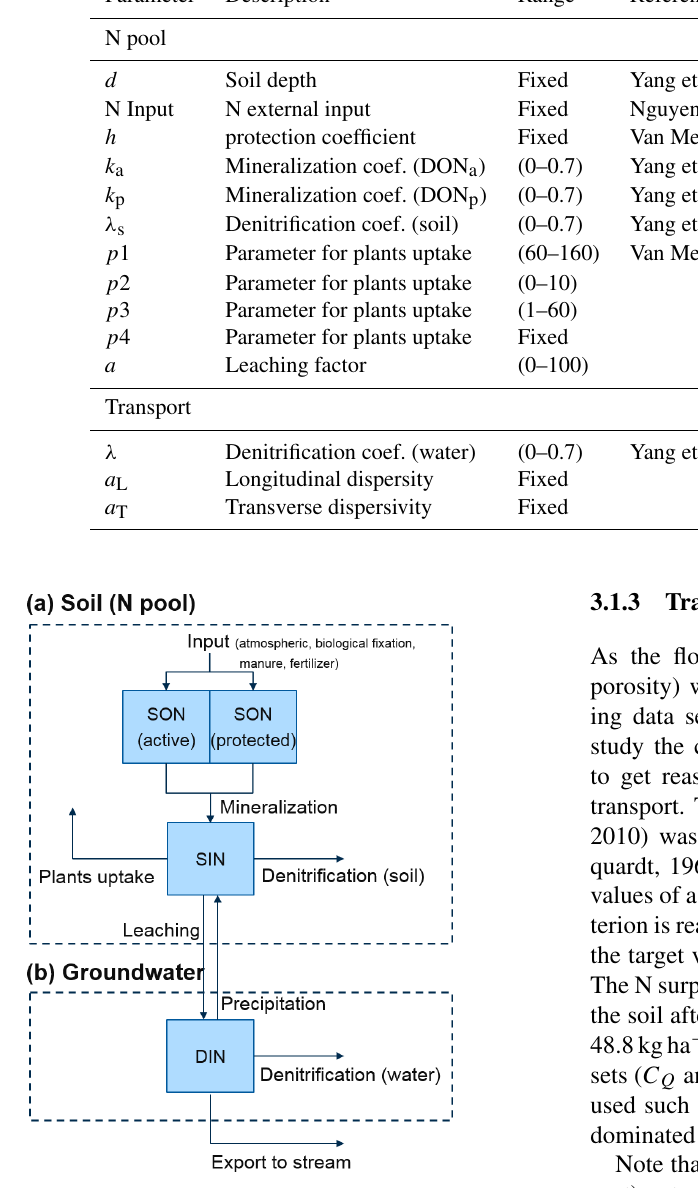
Figure 2. Conceptual framework for nitrogen (N) fluxes (a) in the soil (N pool), and (b) after leaching into the groundwater.